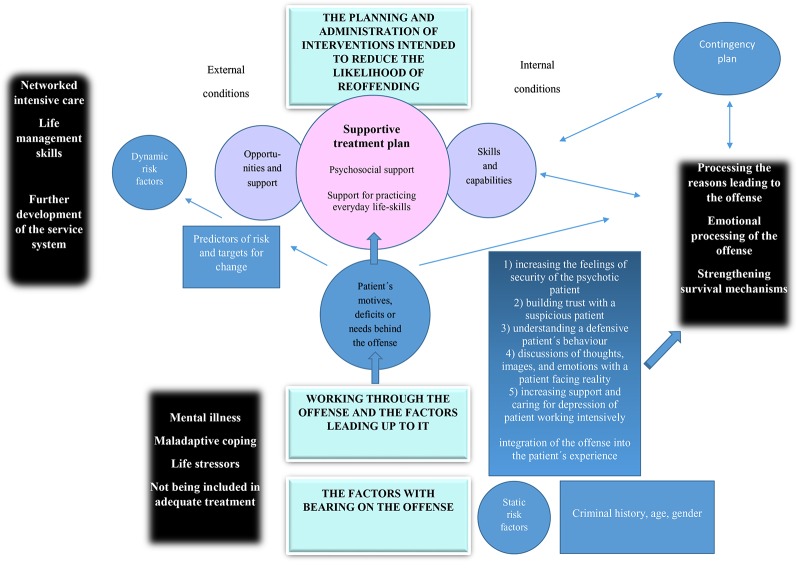
Summary of results.